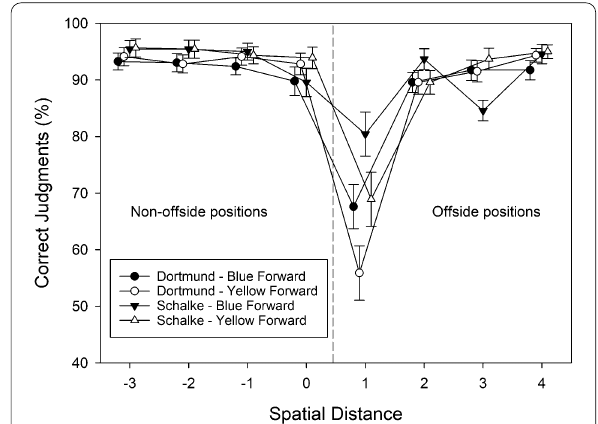
Fig. 9 The percentage of correct offside judgments observed in Experiment 4, plotted as a function of spatial distance (between forward and defender), participants’ team preference (Dortmund vs. Schalke), and shirt colour of the attacking team (blue vs. yellow). Error bars represent standard errors between